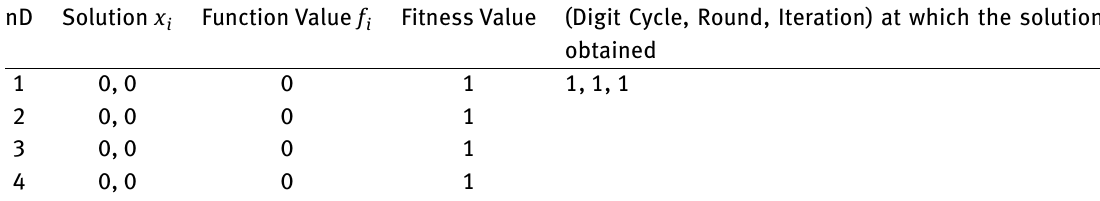
Table 8: Digit Cycle Results for Ackley’s function with 2 variables